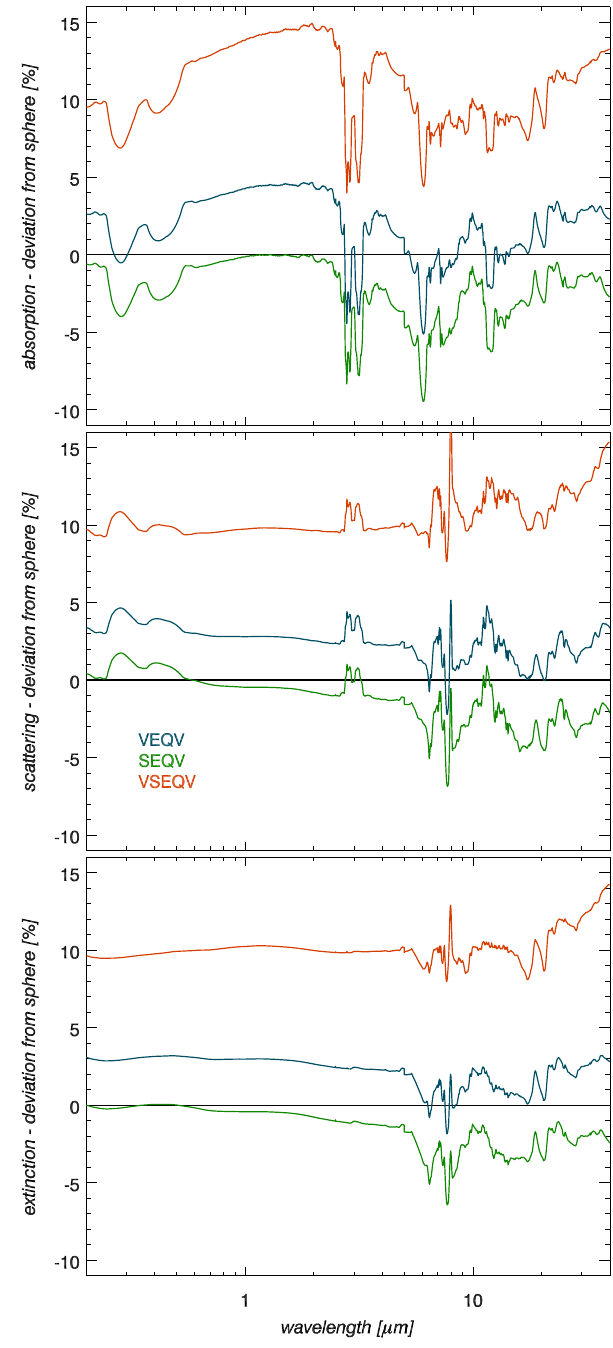
Fig. 11. The same as in Fig. 10, but for absorption (top), scattering (centre) and extinction coefficient (bottom) at ground level of OZT (1150m